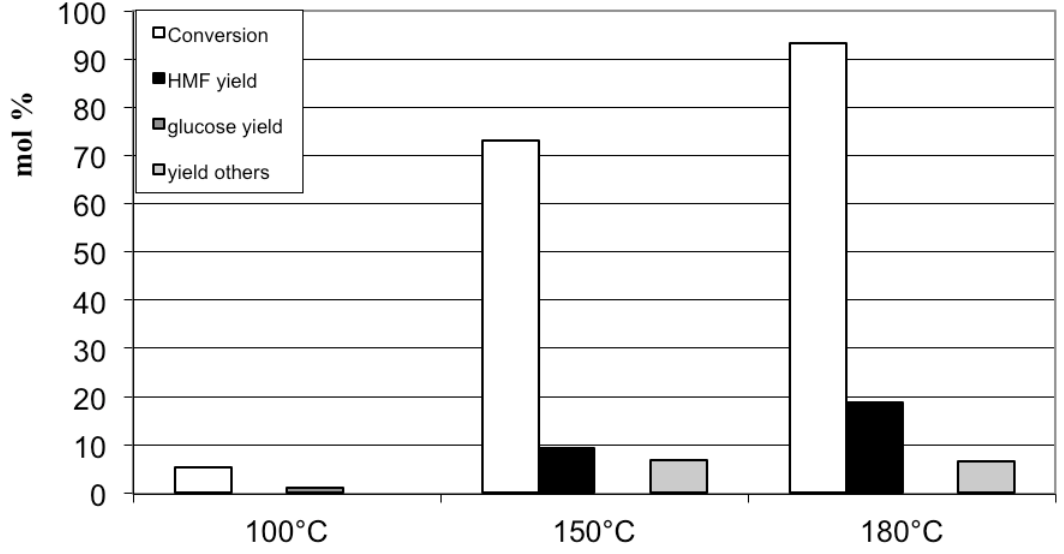
Figure 8. Fructose conversion in aqueous media at 150 °C in the presence of NbOH as a function of the temperature.